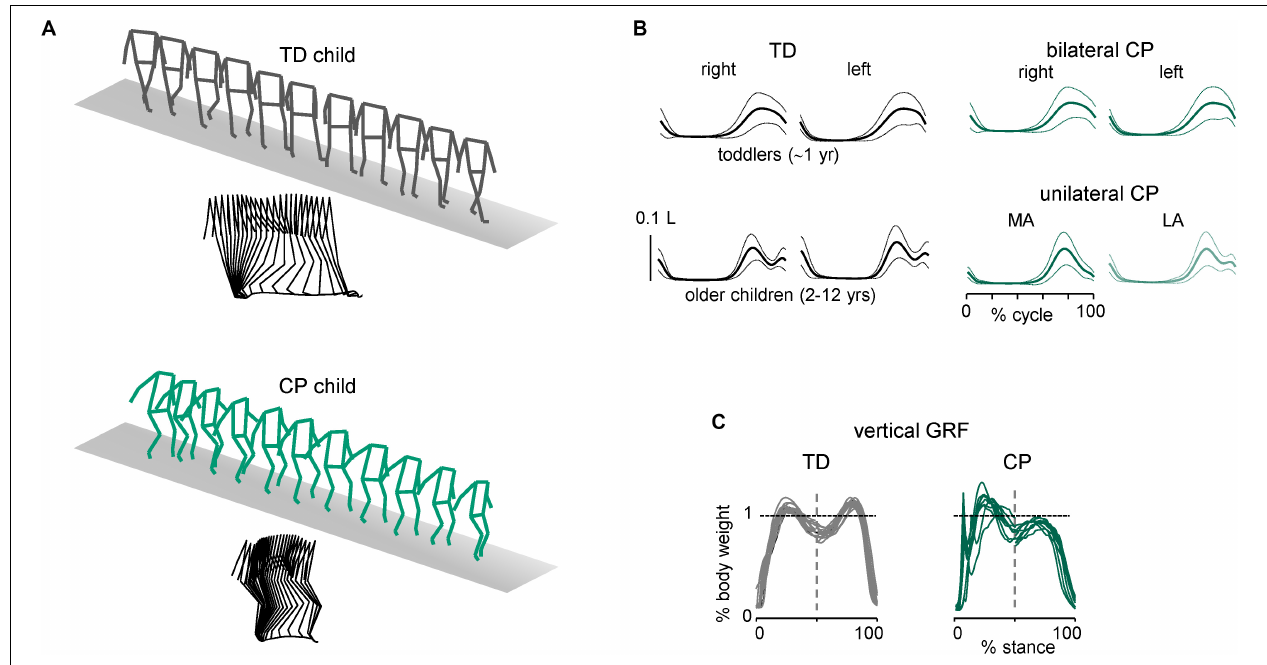
FIGURE 1 | Distinctive features of ground reaction forces and foot trajectory control during walking in children with cerebral palsy. (A) Stick diagrams (both 3D and sagittal) of 1 stride in one TD child (5.7 years) and one child with bilateral CP (5.4 years). Note typical two peaked profile of vertical hip position during one stride in TD child (pendulum mechanism of walking) and variable pattern in child with CP. (B) Ensemble-averaged (across subjects, ± SD) vertical foot movements (normalized by the limb length L). MA, most affected; LA, least affected side. (C) Examples of vertical ground reaction forces in one TD (11.8 years) child and one representative child with bilateral CP (6.1 years). The data from several strides were superimposed (adapted from Cappellini et al.,